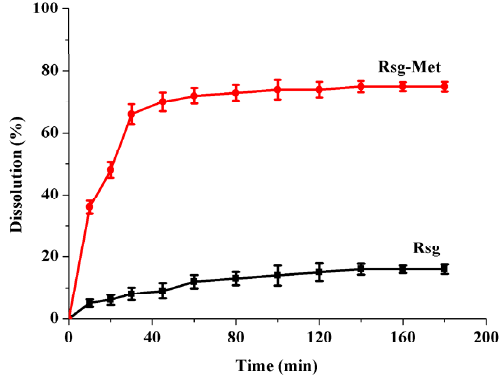
Figure 6. Dissolution rate of Rsg and Rsg -Met in alkaline medium (pH = 6.8).